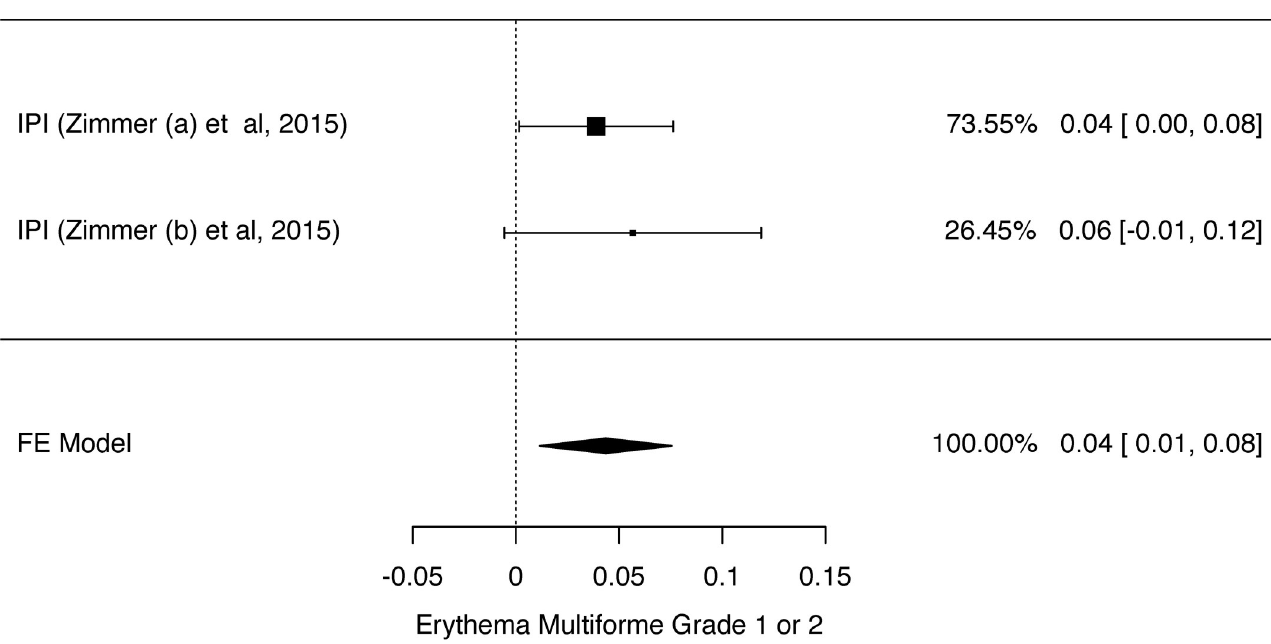
Fig 5. Meta-analysis of erythema multiforme outcome grade 1 or 2. Elaborated by the authors using JAMOVI 1 . Legend: IPI—Ipilimumab.